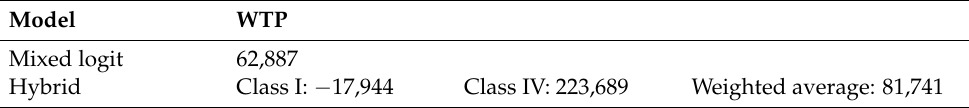
Table 9. Willingness to Pay (W2P) for P2P ETS (KRW per month).